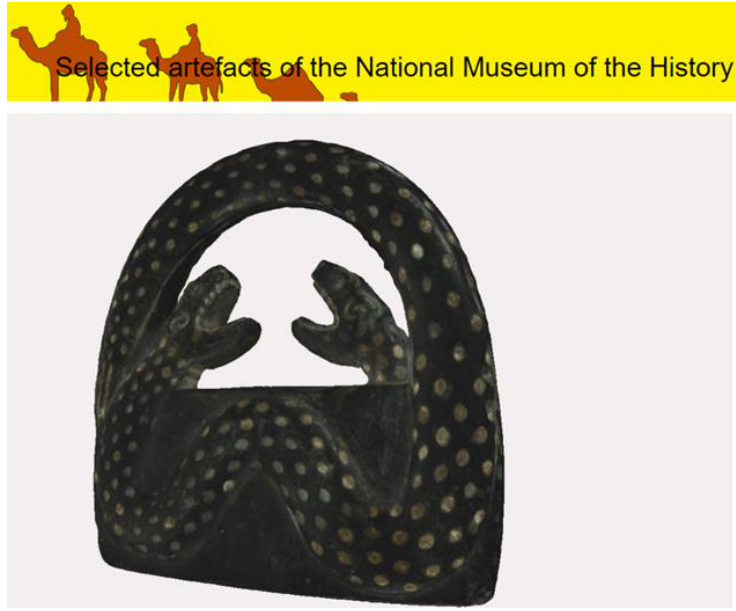
Figure 8. 3D dissemination model of the “Snake” figure